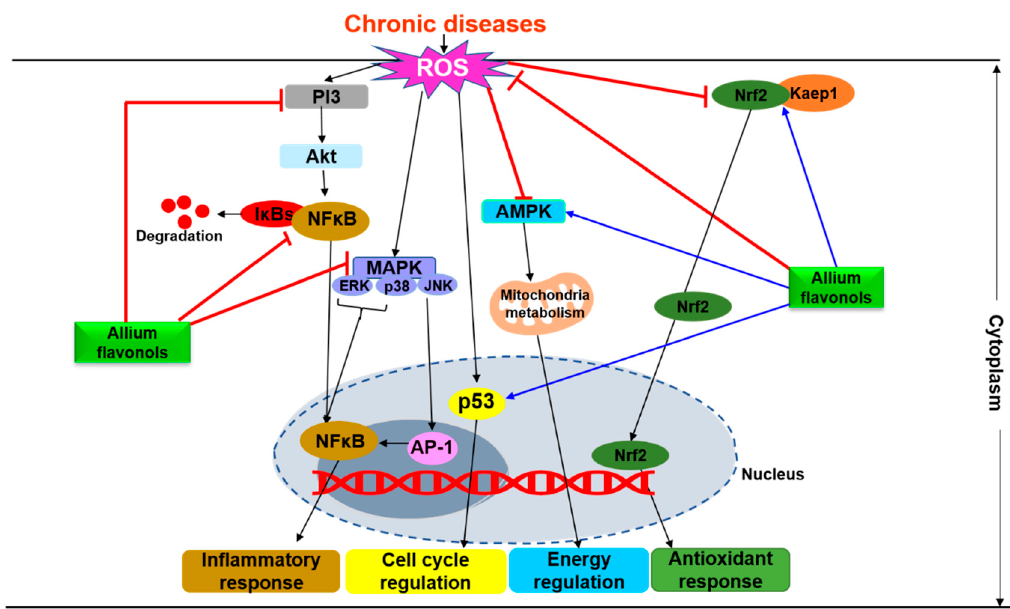
Figure 3. Examples of some molecular targets of Allium -derived flavonols during a chronic disease condition. Blue line indicates activation; red line indicates inhibiton; black line indicates pathways. AMPK, AMP-activated protein kinase; AP-1, Activator protein-1; ERK, extracellular signal-regulated kinase; JNK, jun N-terminal kinase MAPK, mitogen-activated protein kinase; PI3, phosphatidylinositol 3-kinase; Akt, protein kinase B; ROS, reactive oxygen species; NF- κ B, nuclear factor kappa-light-chain-enhancer of activated B cells; Nrf2, nuclear factor erythroid 2-related factor 2.